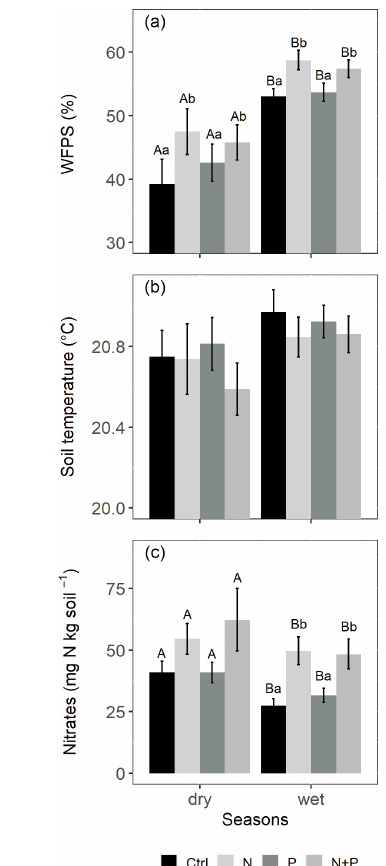
Figure 1. Mean ( ± SE, n = 4) WFPS (a) , soil temperature (b) , and nitrates (c) in the top 0.05m of the control (Ctrl), nitrogen (N), phos- phorus (P), and N + P plots of the nutrient manipulation experiment measured during the dry (January and February; monthly precipi- tation < 100mm) and wet (March to December; monthly precipi- tation > 100mm) seasons. Different lowercase letters indicate the significant differences between treatments and the control, while different uppercase letters indicate significant differences between seasons (LMEMs; p ≤ 0 .